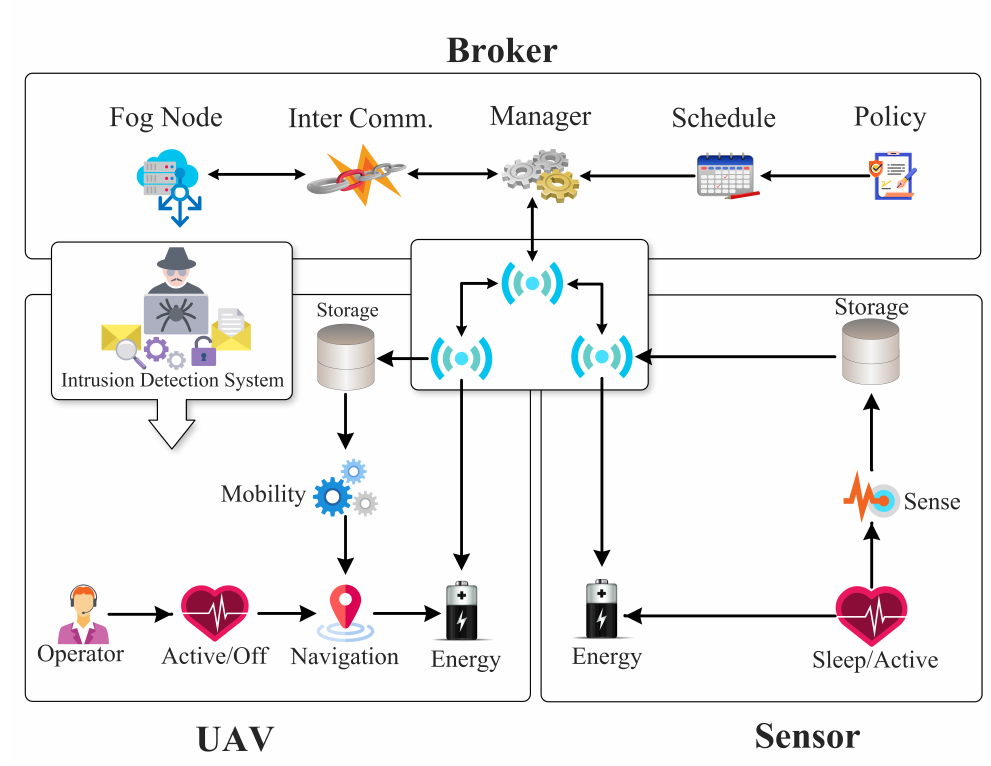
Figure 3. Detailed Architecture Diagram of Proposed